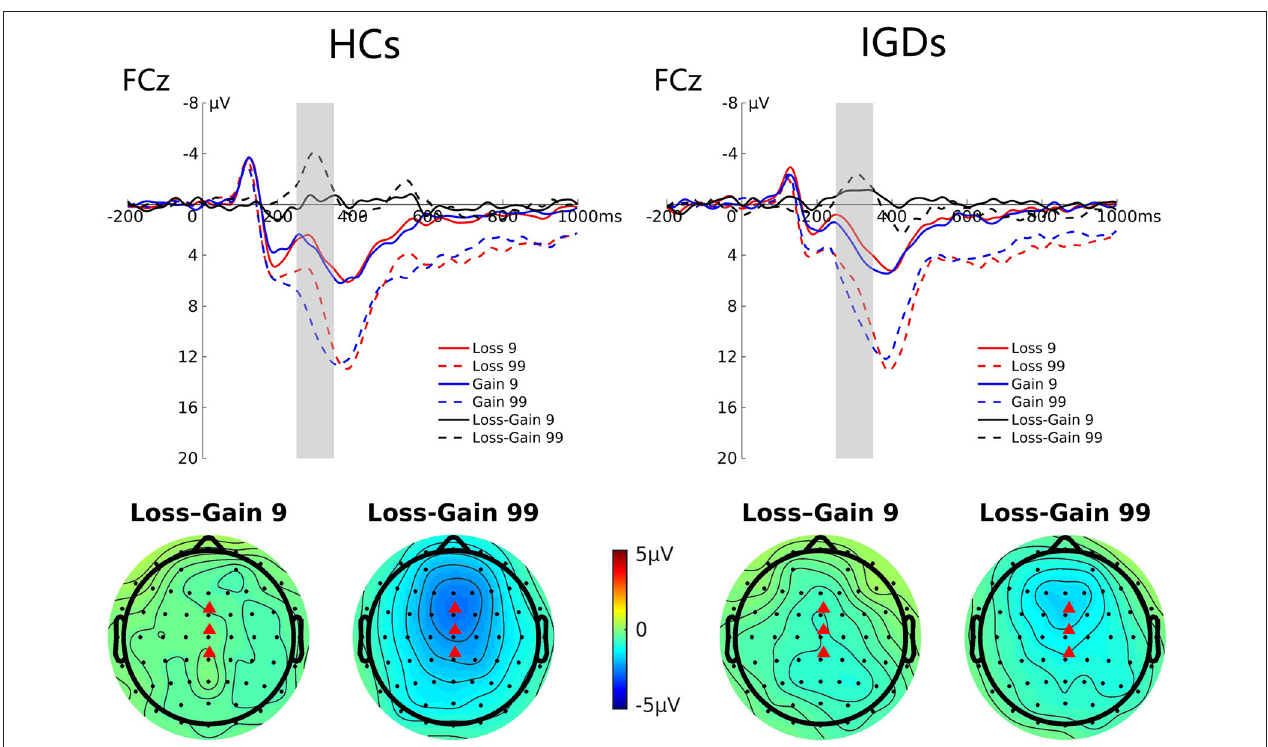
FIGURE 3 | Grand average ERP waveforms following low- and high-risk decisions for HCs and IGDs at FCz. The upper figure shows the ERP waveforms for HCs and IGDs at FCz. FRN is calculated as the difference between loss and gain waveforms after feedback, and the time window was depicted as the shaded areas. The lower figure shows the topographic maps on time window